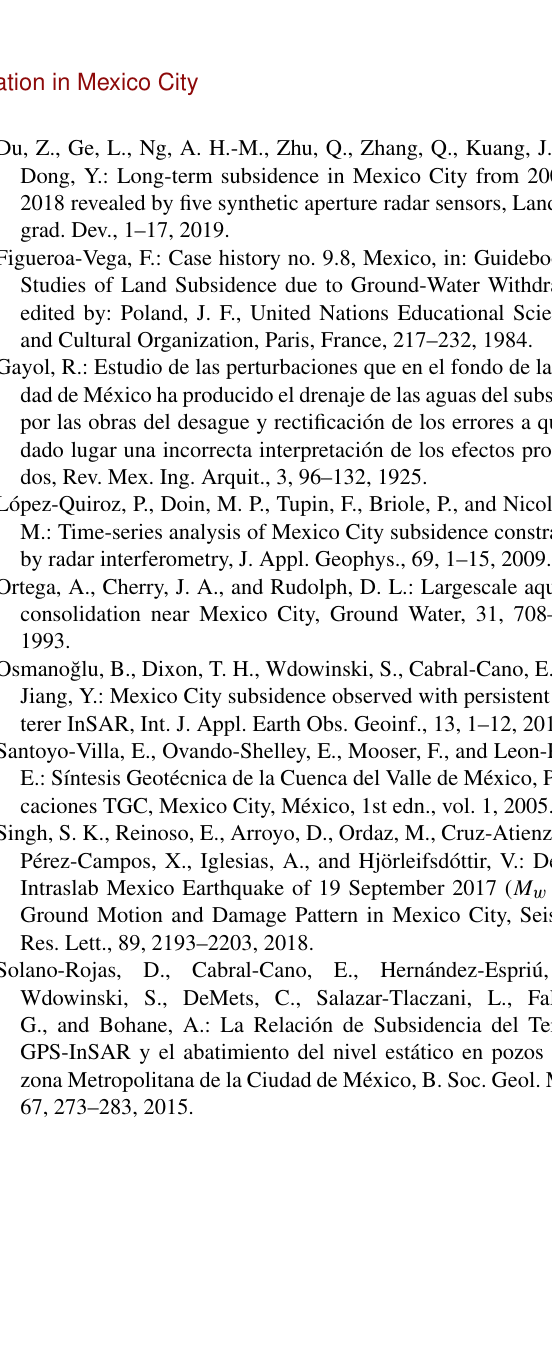
Figueroa-Vega, F.: Case history no. 9.8, Mexico, in: Guidebook